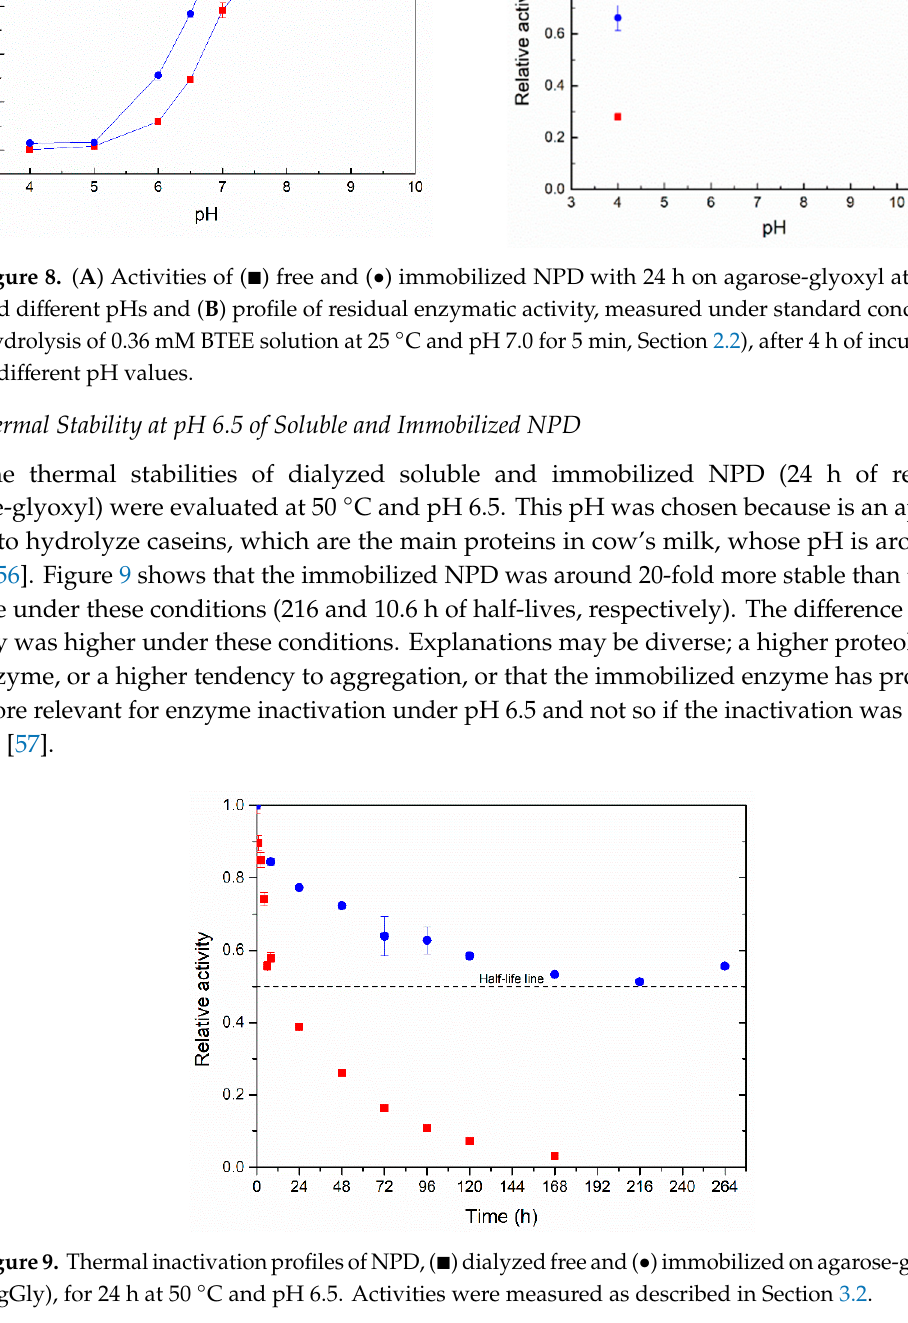
Table 1. Recovered activities (RA) of low- and high-loaded NPD derivatives (24 h reaction at 20 °C and pH 10) measured with small (BTEE) and large (casein) substrates. Protein Loaded (mg/g)